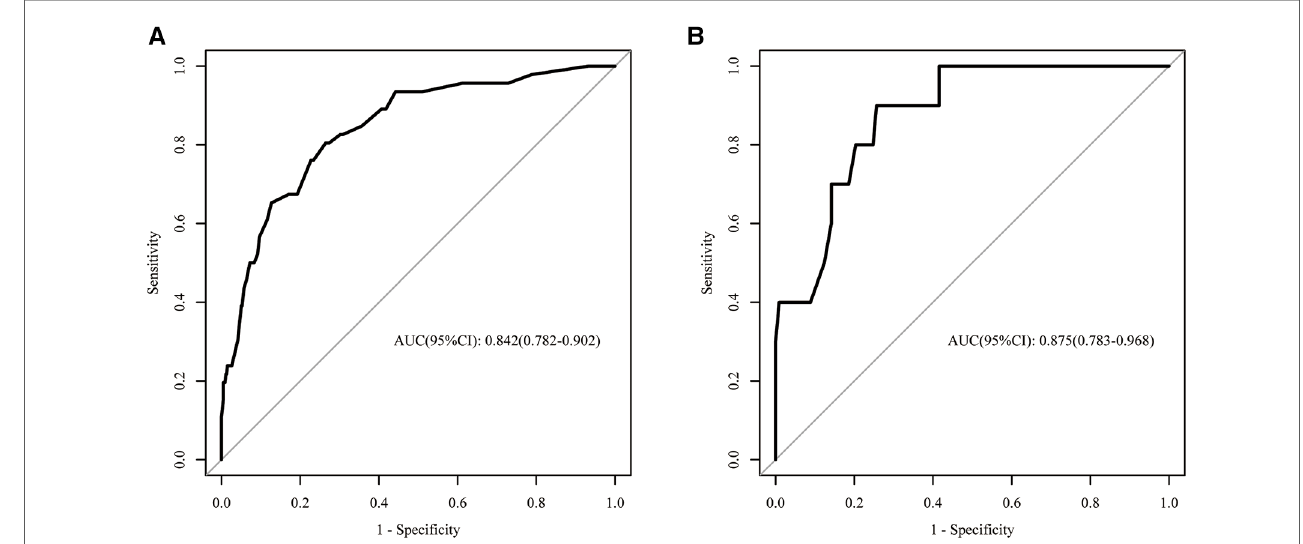
FIGURE 2 Receiver operating characteristics curves in the training set ( A ) and validation set ( B ).